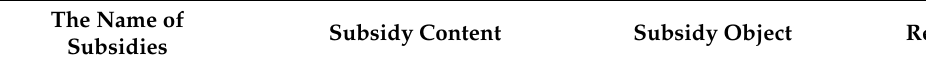
Table 2. Subsidies related to DWP control in